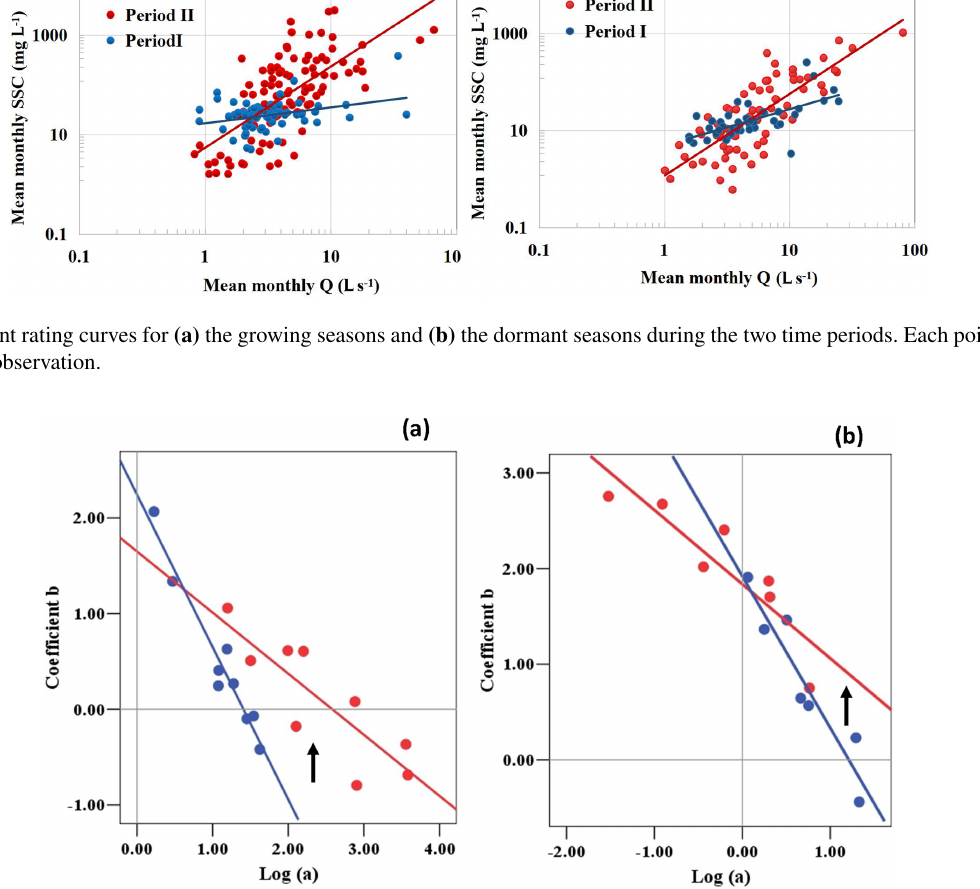
Figure 6. Relationship between coefficients a and b for (a) the growing season and (b) the dormant season during Period I (blue) and Period II (red), respectively. log ( a ) on the x axis represents the decadal logarithm. The arrows represent the shift in the sediment regime between Period I and Period II (see text below). All regressions are significant at p< 0 . 05.